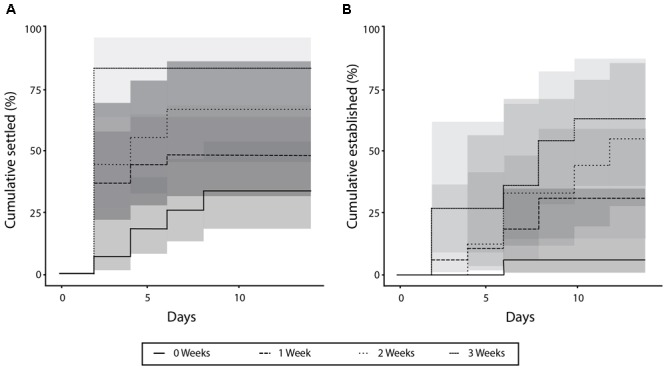
Percent of fragments settled (A) and established (B) over 14 days for each the four age treatments.